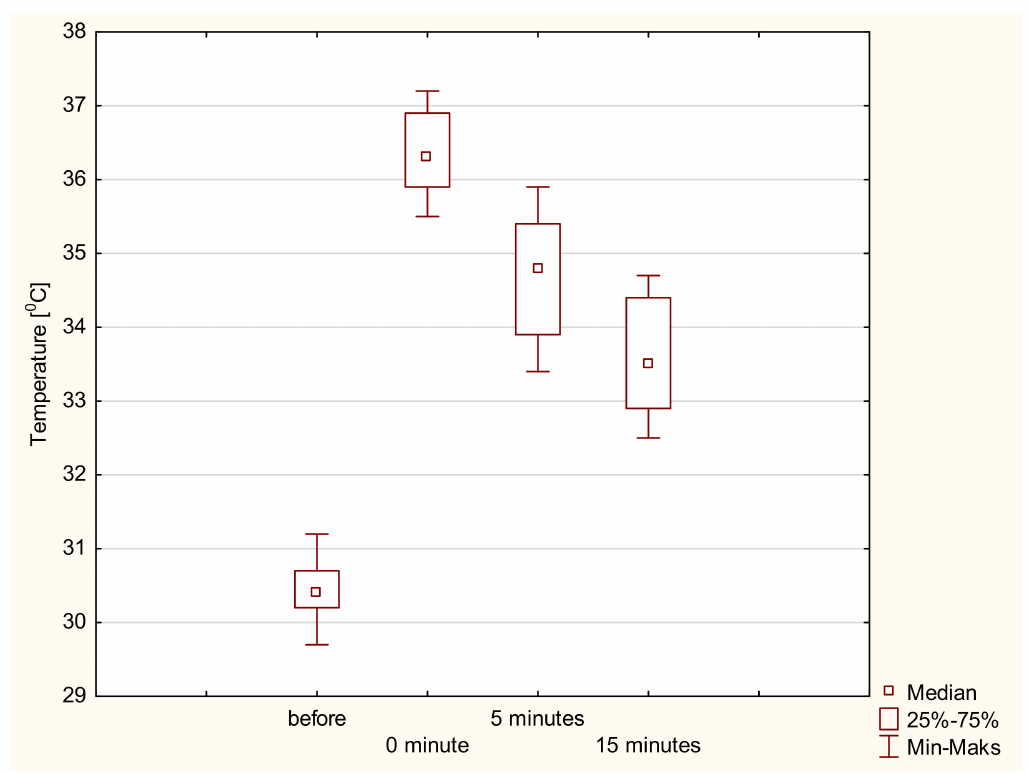
Figure 5. Changes in tissue temperature values as a result of using a capacitive electrode.